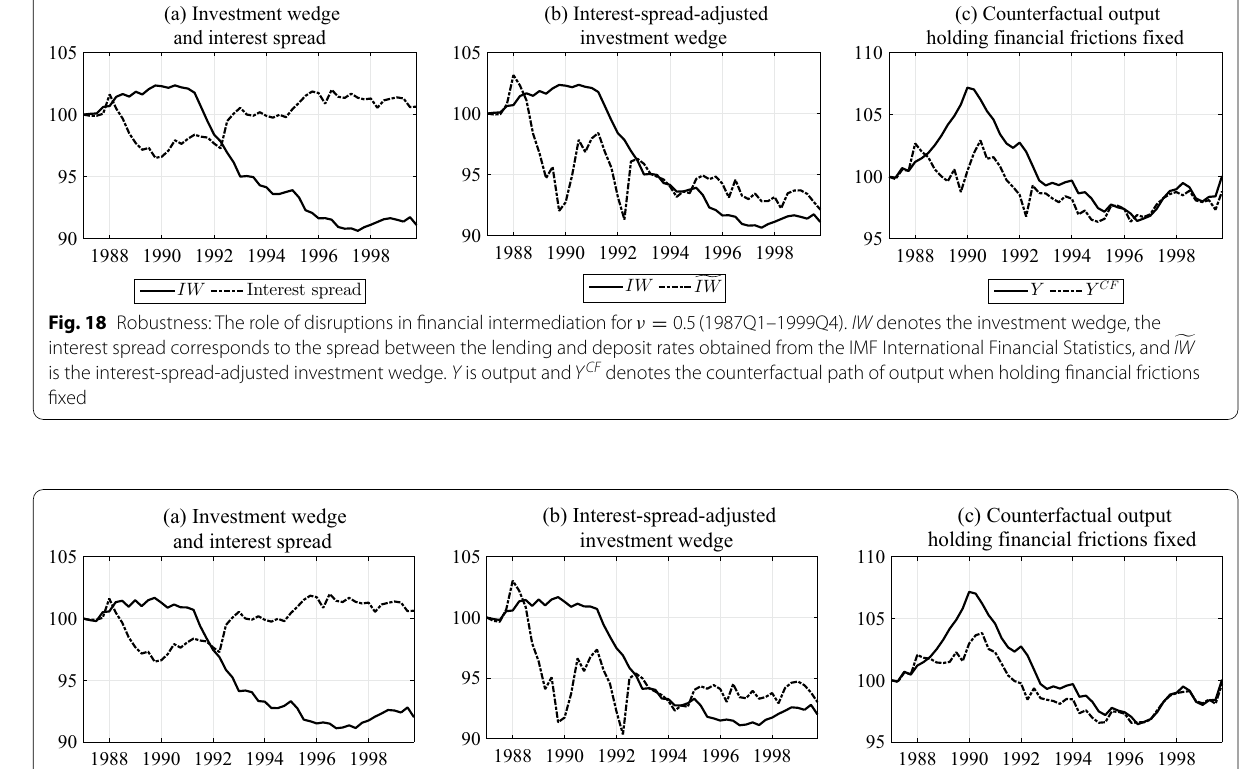
IW is the (cid:31)